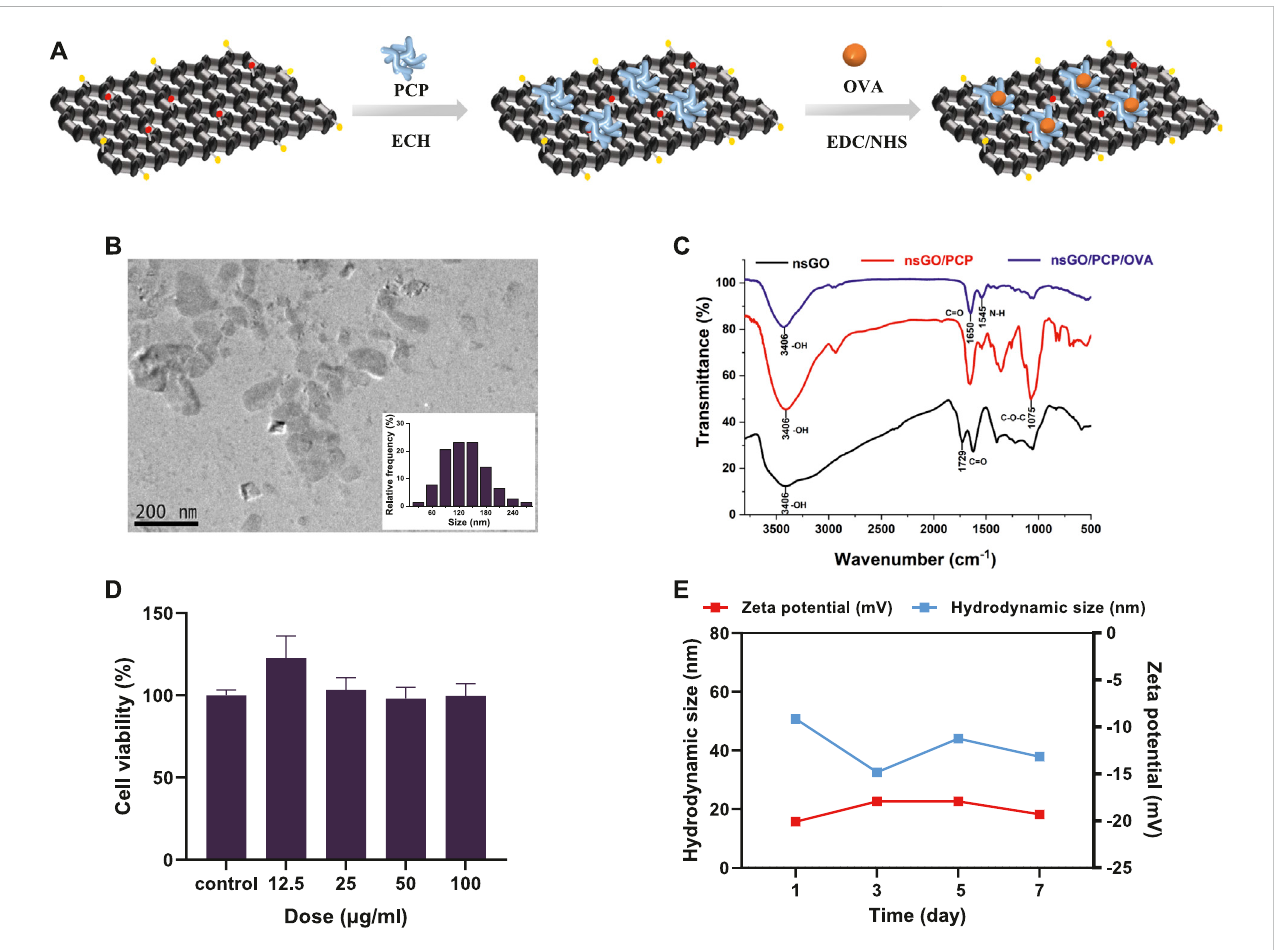
FIGURE 1 Preparation and characterization of nsGO/PCP/OVA. (A) Schematic representation for the preparation of nsGO/PCP/OVA. (B) TEM image and size distribution of nsGO/PCP/OVA. The inset in (B) is the size of nsGO/PCP/OVA nanoparticle. (C) FT-IR spectra of nsGO, nsGO/PCP and nsGO/PCP/OVA. (D) ζ potentials and size distribution of nsGO/PCP/OVA for aweek. (E) Viability of DC2.4 cells after nsGO/PCP/OVA treatmentwas evaluated by CCK-8 assay. Data shown are representative of 3 replicate